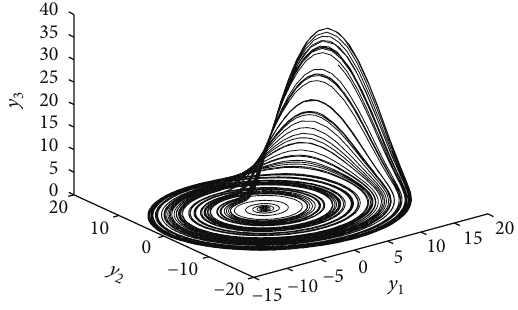
Figure 3: Dynamical behavior of the chaotic system in case 2.